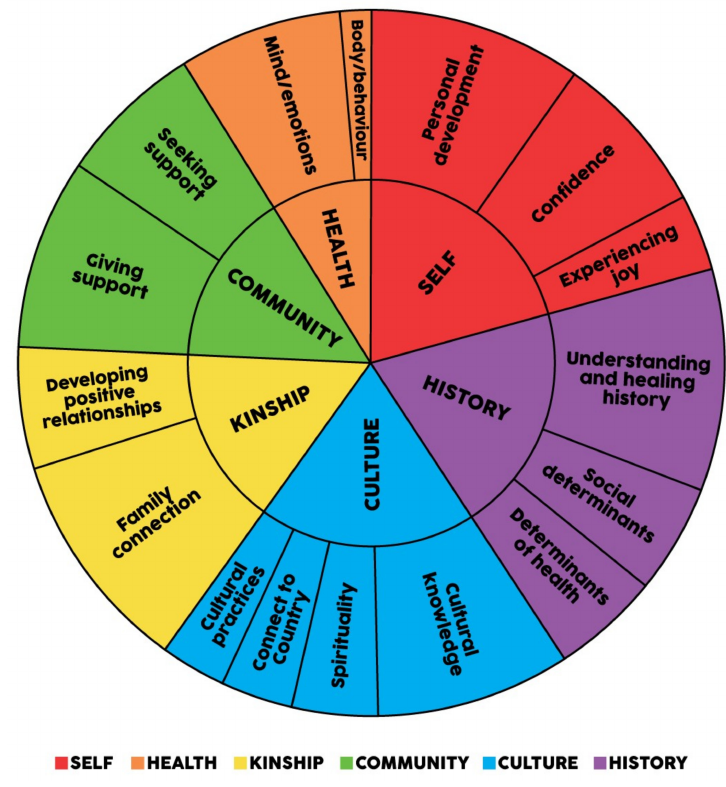
Figure 3. Thematic map of